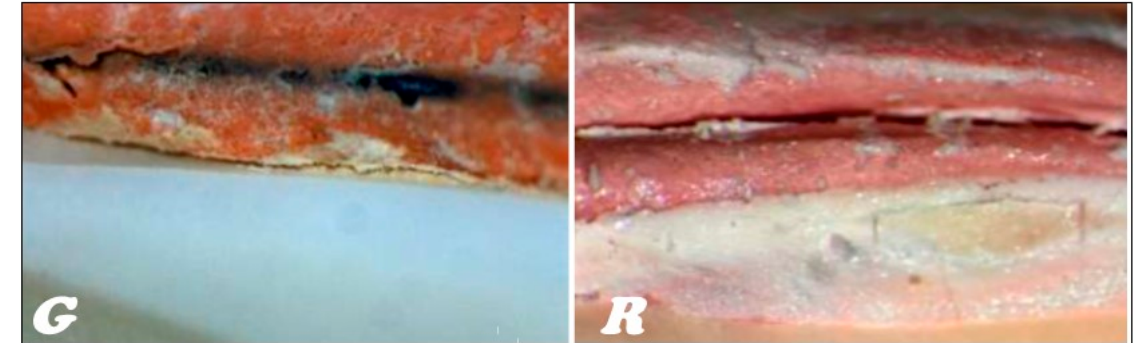
Figure 18. Leakage between the central stud and additional studs of the filling material due to insufficient share of the sealant and thus non ‐ fusing of the central and additional studs, and with the dentin wall after obturation with material based on gutta ‐ percha ( G ) and resilon ( R ); LSM.